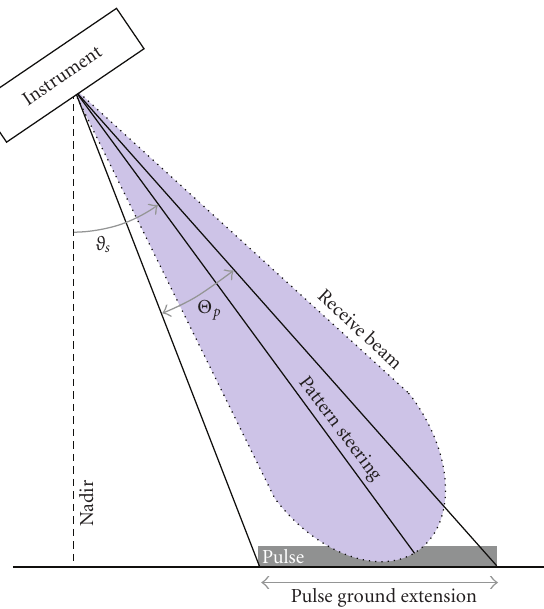
Figure 4: SCORE pattern loss SPL . Figure 5: Pulse extension loss PEL